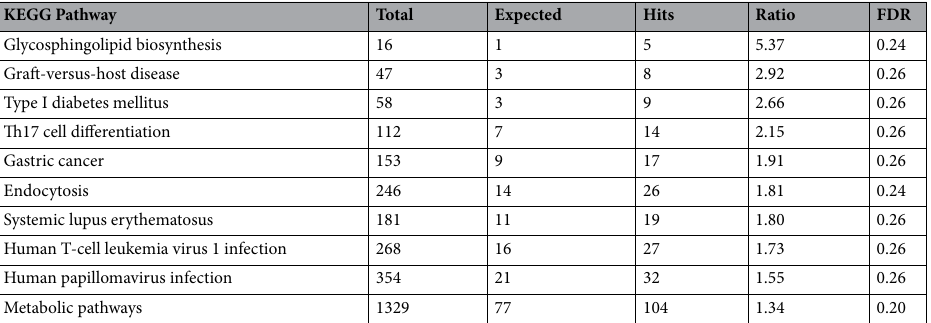
Table 2. First 10 most overrepresented KEGG pathways for a list of 2075 Ensembl gene ID from genes positioned in transmission ratio distortion genomic regions associated with strong gametic interaction. KEGG Kyoto Encyclopedia of Genes and Genomes, Total total number of genes associated with the KEGG pathway, Expected expected number of genes within the network dataset associated with each KEGG pathway, Hits observed number of genes within the network dataset associated with each KEGG pathway, Ratio Ratio of overrepresentation, FDR false discovery